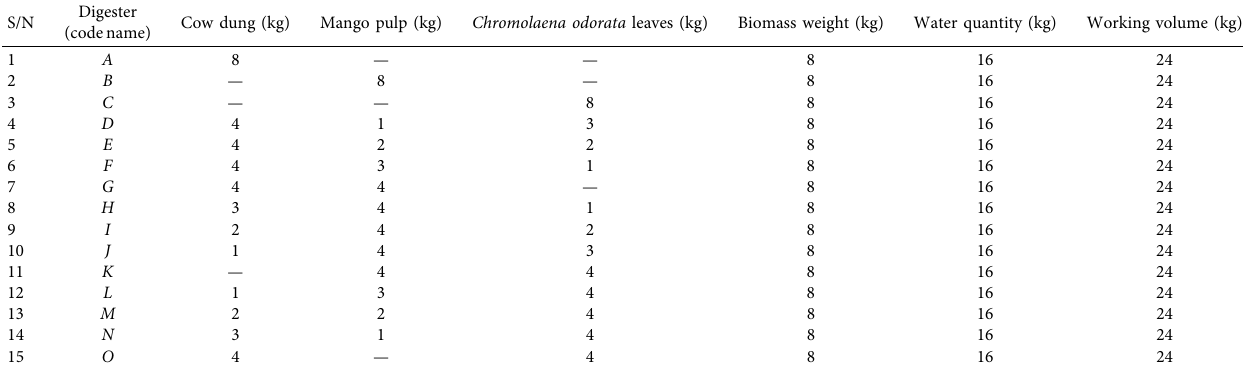
Table 2: Experimental biomass